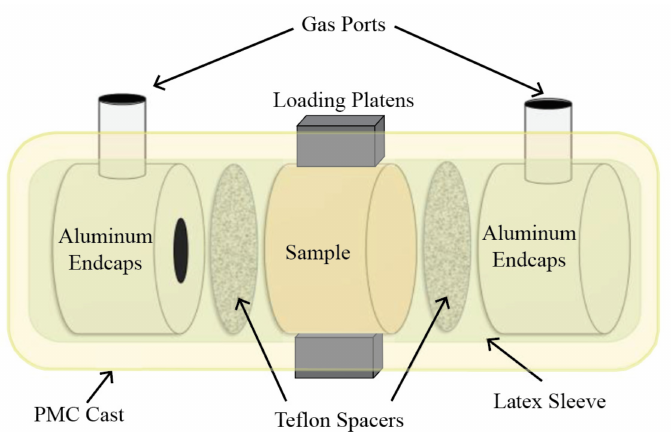
Figure 3. Schematic of the sample jacketing construction modified from Boyce